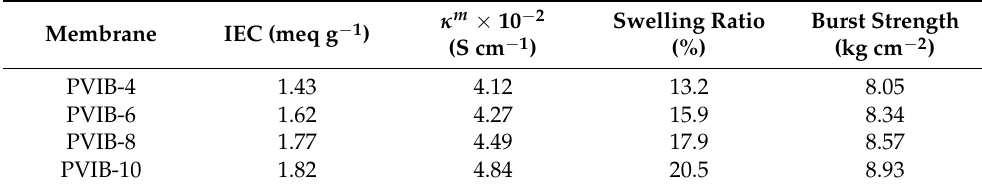
Table 1. Physicochemical, electrochemical and mechanical parameters for the series of PVIB anion-exchange membranes prepared in this work. The codes applied to the different membranes indicate the weight % of (vinylbenzyl) trimethylammonium chloride added during synthesis, as mentioned in the text.